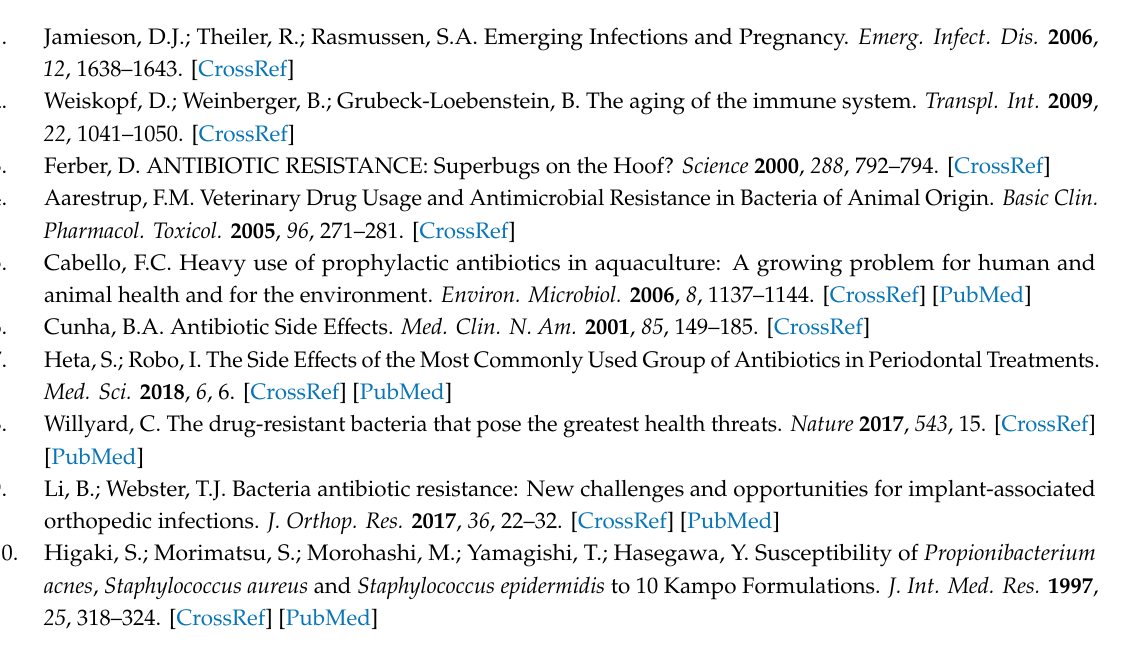
Supplementary Materials: The following are available online, Figure S1: Structural formulas of eight compounds estimated to be AR-derived ingredients within the non-targeted analysis of plasma harvested from AR- or MBST-treated rats, Figure S2: MS and MS / MS information used in the identification of methyl kakuol and (2 E ,4 E ,8 Z ,10 E )- N -isobutyl-2,4,8,10-dodecatetraenamide via LC-HRMS analysis, Figure S3: Representative SRM standard substances, as well as blank plasma, and plasma collected at 1 h after the administration of 1 g / kg of MBST, Table S1: List of AR ingredients incorporated into UNIFI software, Table S2: Targeted LC-MS / MS methods: ion parameters of test